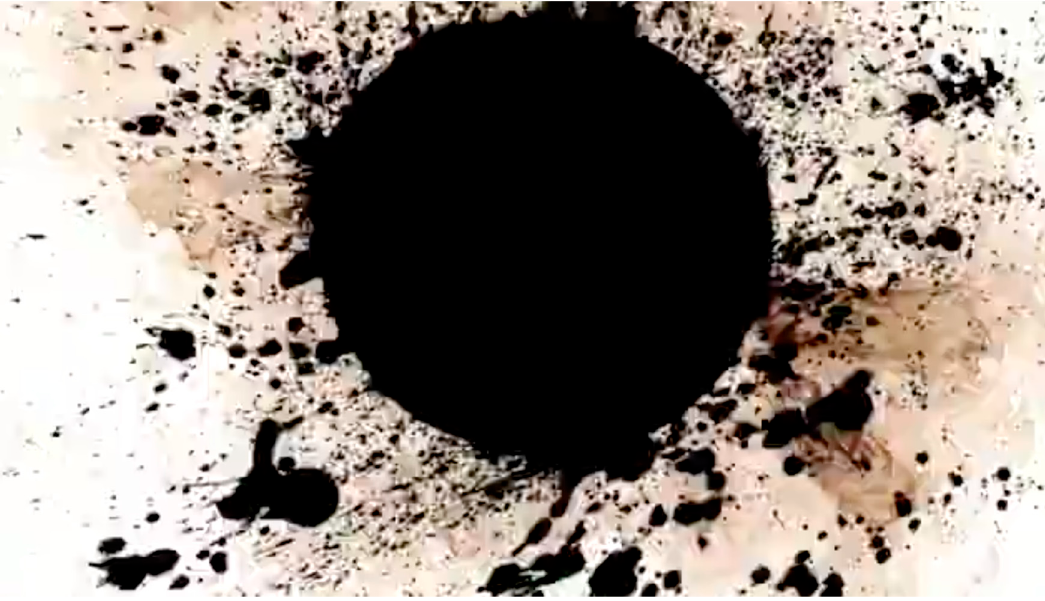
Figure 2. The black sun burns until all is black. Frame capture, The Pride of Strathmoor (Baldvin 2014).